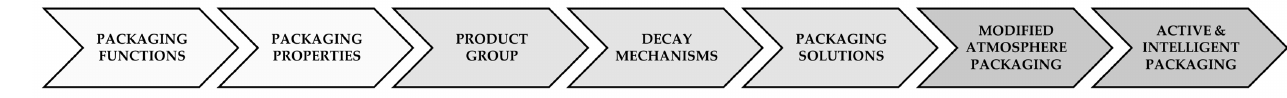
Figure 1. Outline of discussed topics, based on the review’s aims.